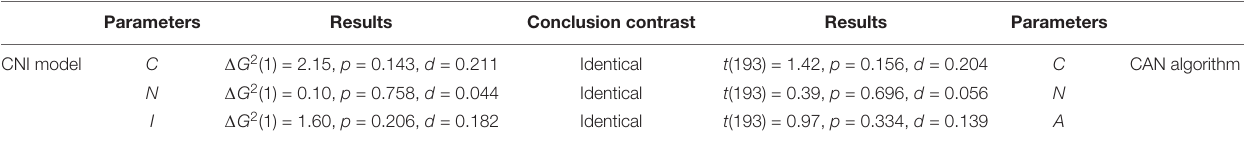
TABLE A7 | Test of differences in harm salience with the CNI model and CAN algorithm in Study S1a by Gawronski et al. (2017). Parameters